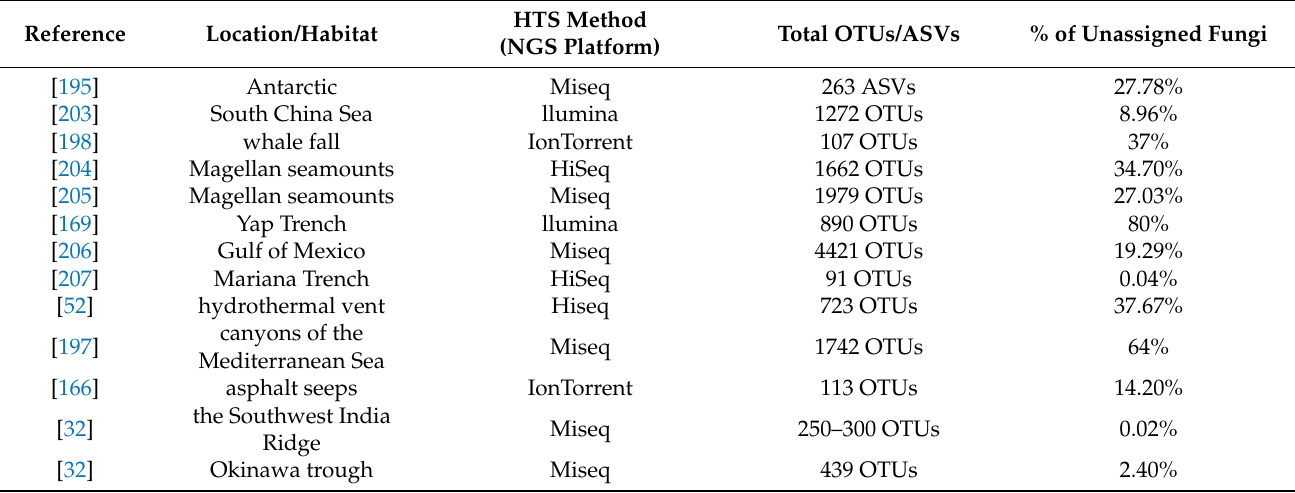
Table 1. Summary of important HTS studies based on the ITS sequence data of deep-sea habitats since